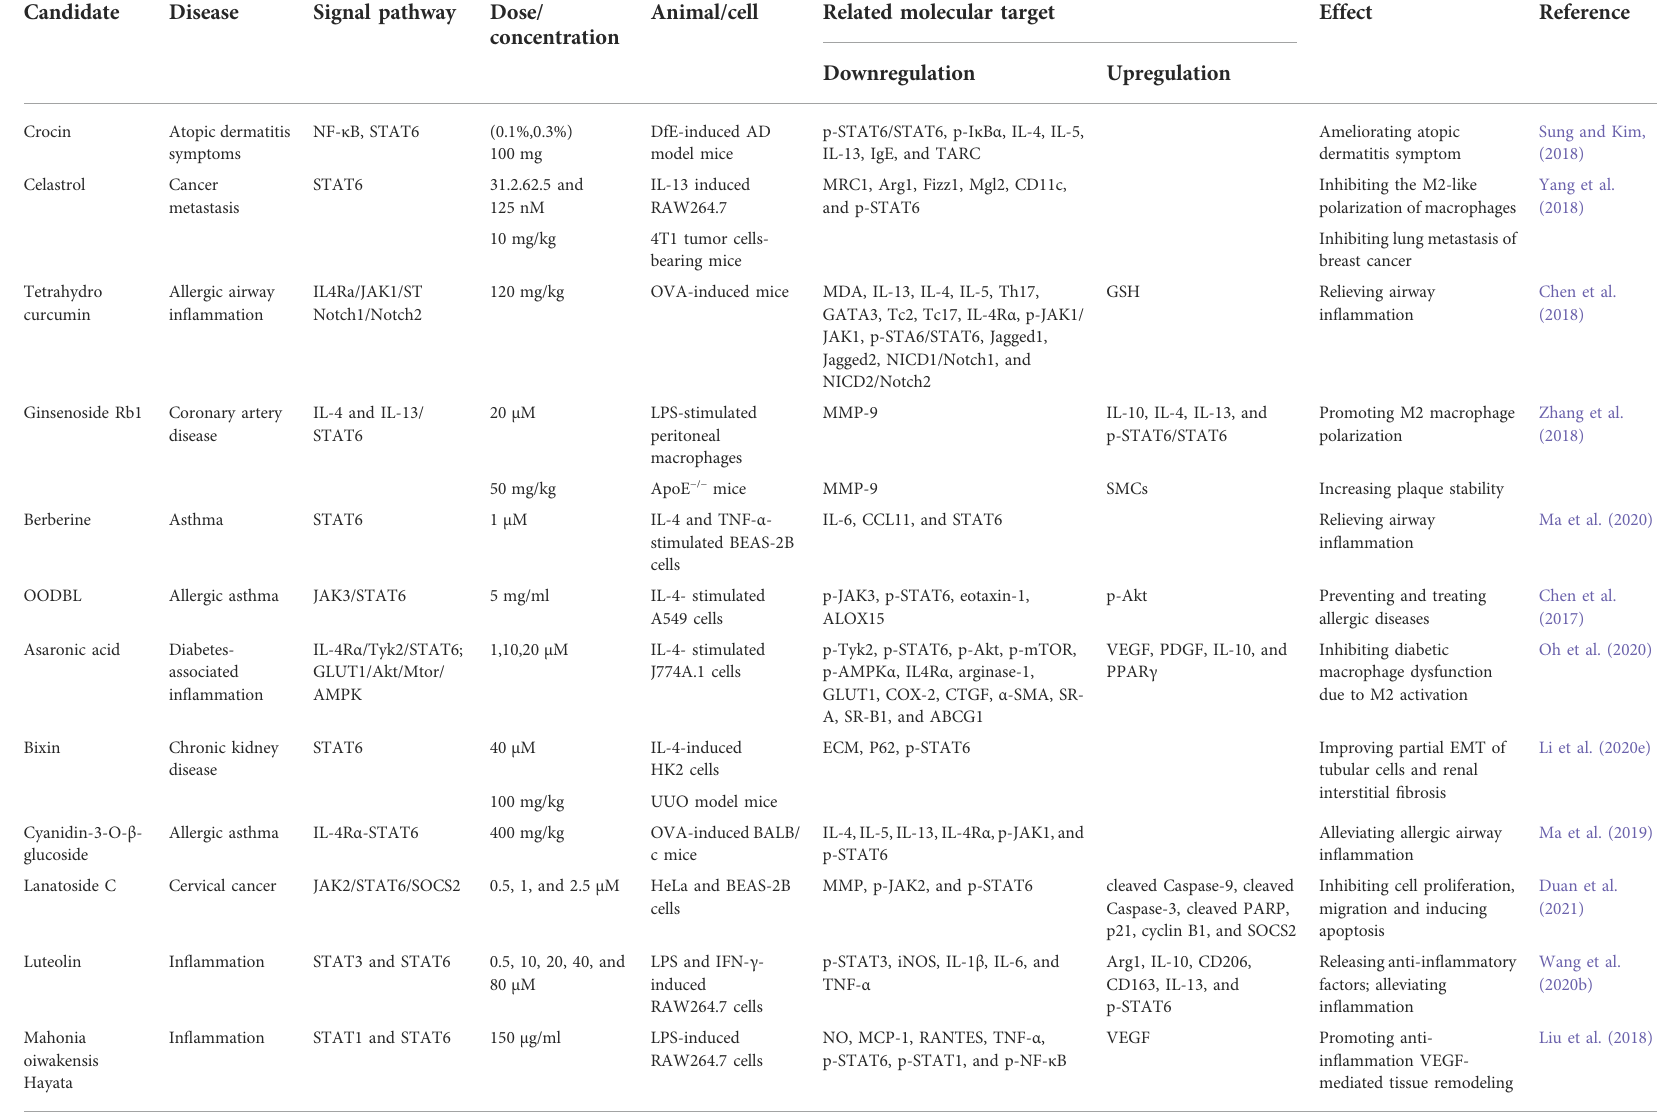
TABLE 6 Chinese herbs and herb formulas, natural compounds, and phytochemicals in the treatment of diseases through regulating